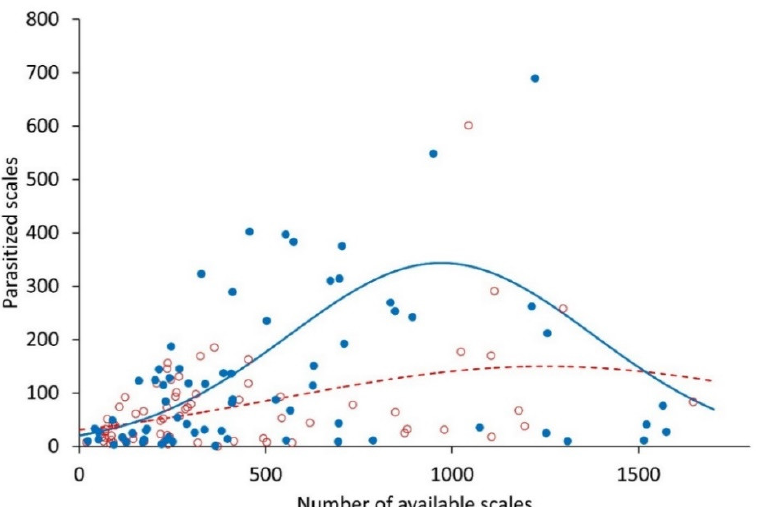
Figure 5. Number of parasitized scales depending on the available scales of stages 2 and 3 in the presence and absence of their mutualistic ant Liometopum apiculatum . Blue circles correspond to the treatment without ants and empty red circles to the treatment with ants. The solid blue line corresponds to the model adjusted for the treatment without ants and the dotted red line at treatment with ants.